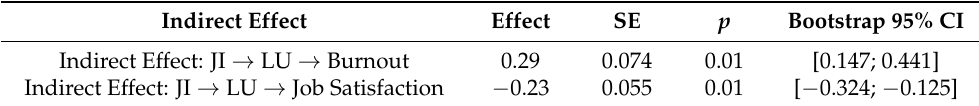
Table 5. Specific indirect effects of the mediated